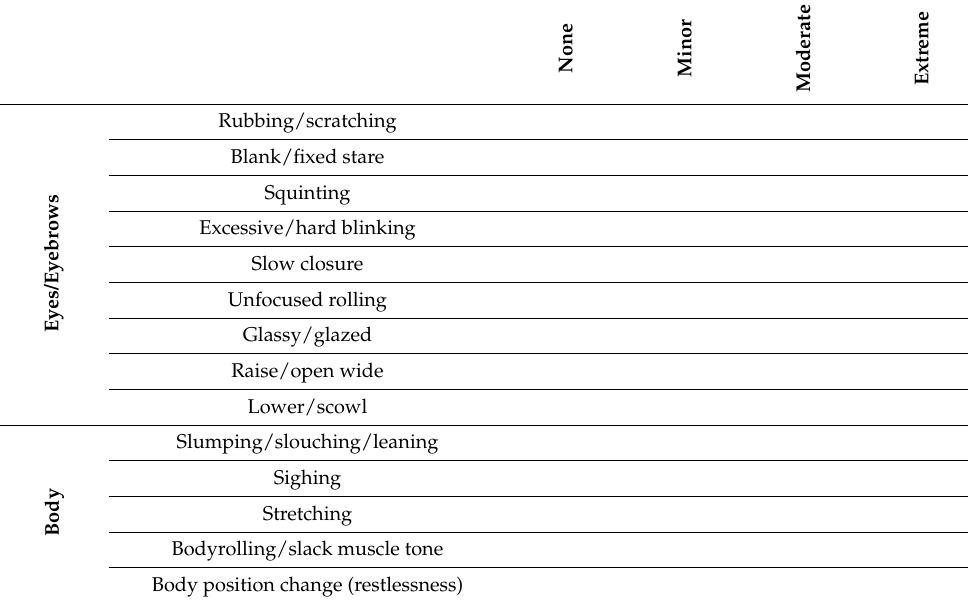
Table A1. ORD Behavior and Mannerism Checklist